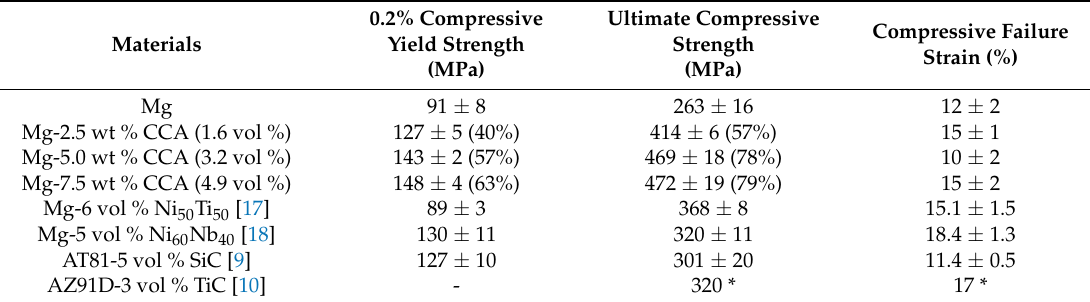
Table 2. Results of room temperature compressive properties.